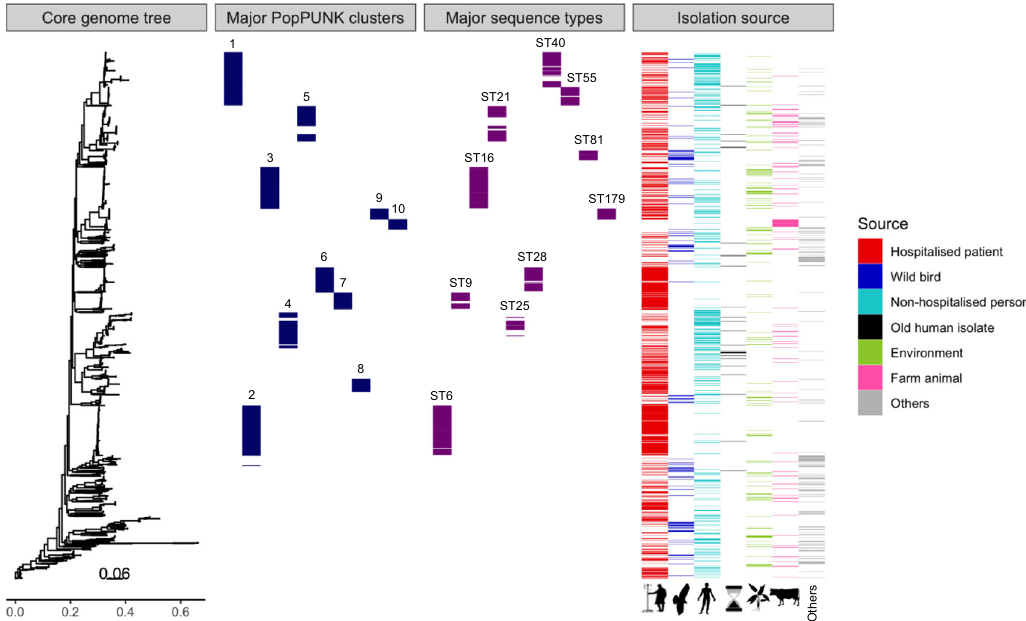
Fig. 1 Overview of the species-wide E. faecalis collection ( n = 2027) depicts interlinkage of the population across host types. First panel, maximum likelihood (ML) phylogeny on mapping-based 68 core-genome alignment, estimated by RaxML v.8.2.8 76 . Second and third panels, coloured blocks depicting the ten largest Population Partitioning Using Nucleotide K-mers (PopPUNK) 19 clusters (blue) and multi-locus sequence types (MLSTs) (purple), respectively, against the species-wide phylogeny. Fourth panel, isolates coloured as per their isolation source: hospitalised patient (red), wild bird (dark blue), non-hospitalised person (light blue), old human isolates (black), environment (green), farm animal (pink) and others (grey). Source data are provided as a Source Data fi